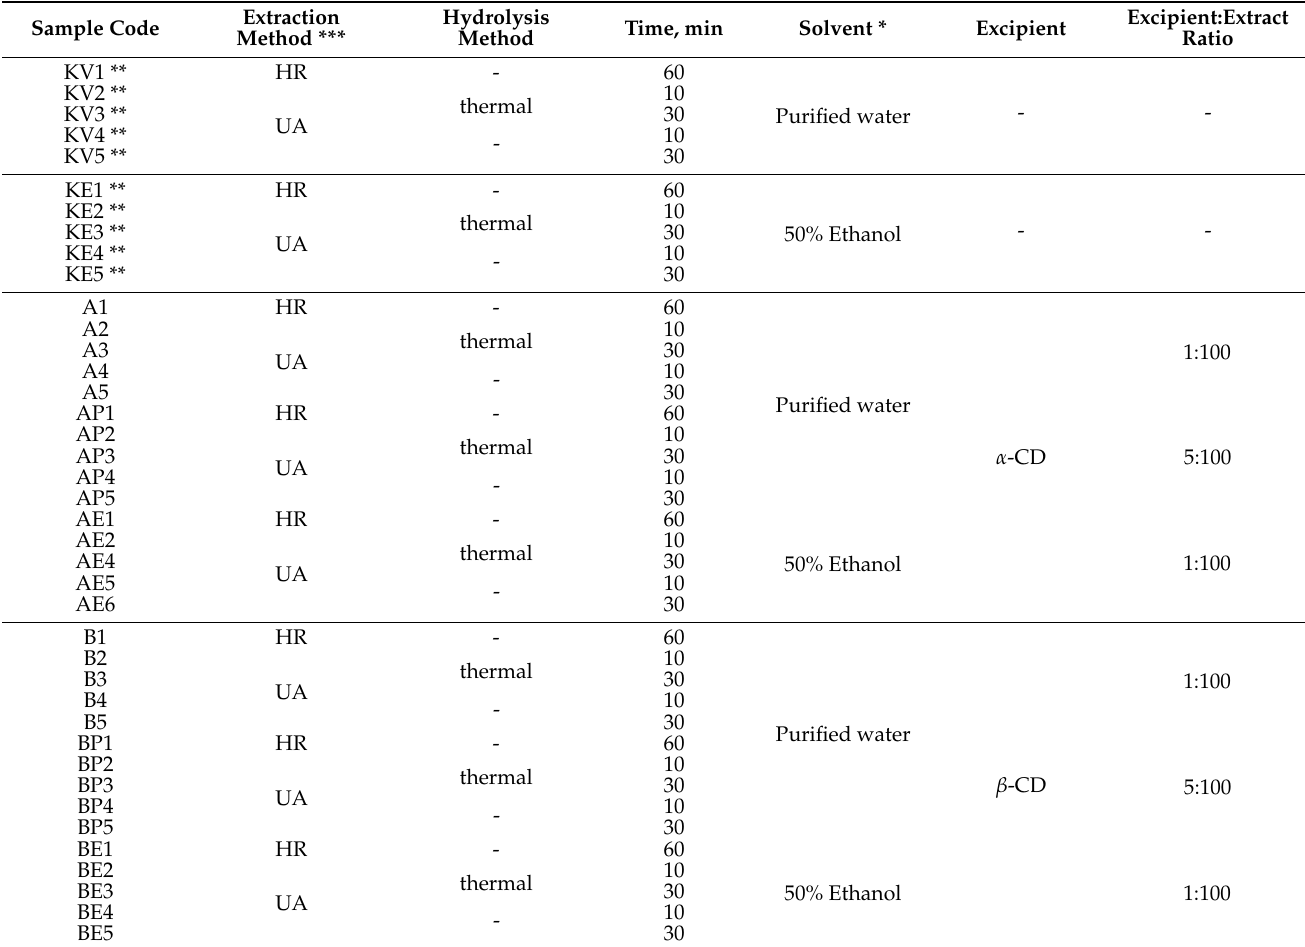
Table 1. Extraction conditions used for the